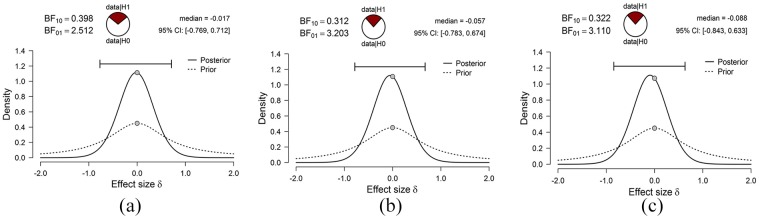
Prior and posterior distributions for the Bayesian t-tests performed on the short-lag discrimination in (a) Experiment 1, (b) Experiment 2a and (c) Experiment 2b.Figures from JASP.